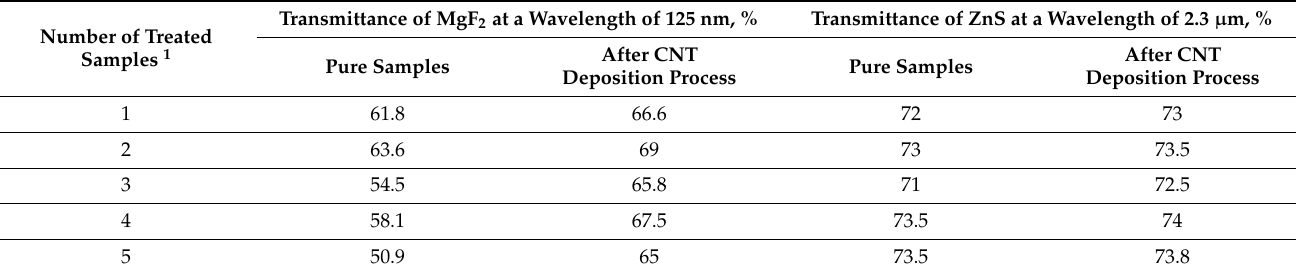
Table 1. Transmittance changes of MgF 2 and ZnS after the deposition of carbon nanotubes.